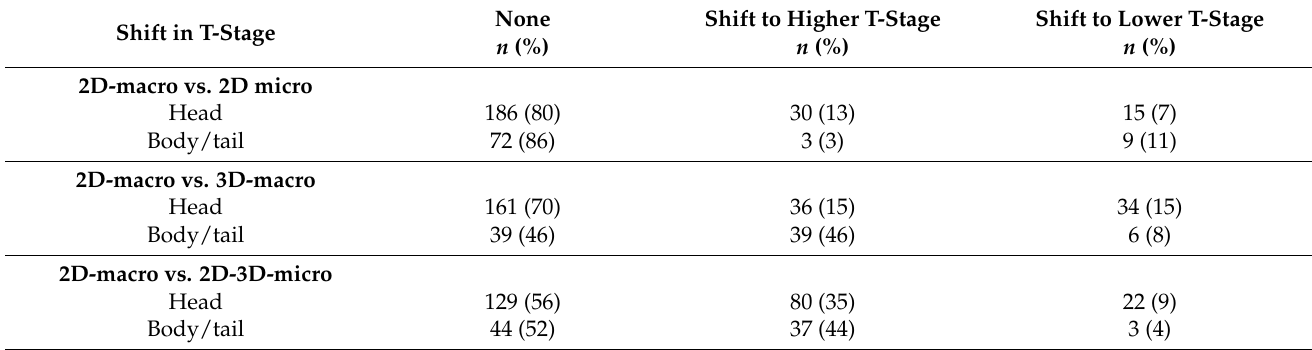
Table 4. Shift in T-stage assignment when comparing various approaches to tumour size